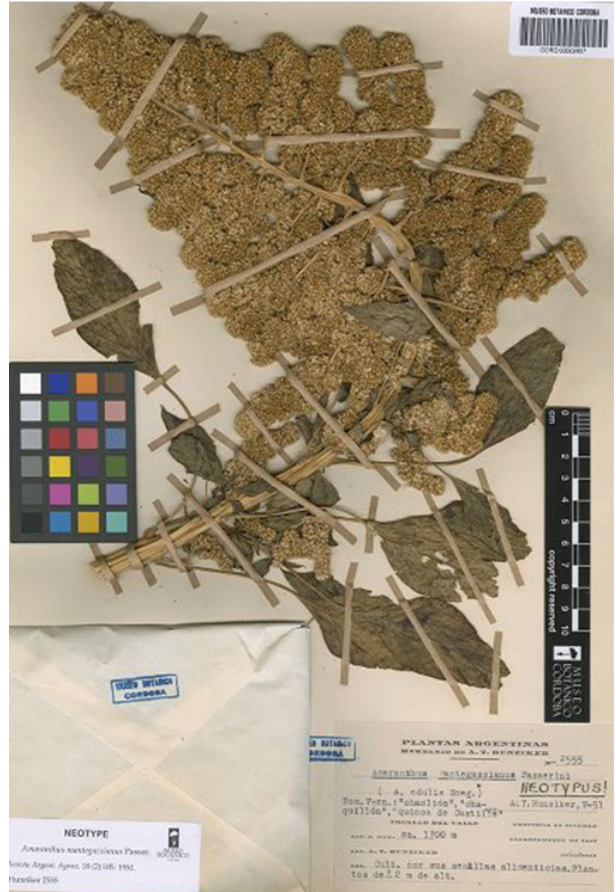
Figure 9. Neotype of the name Amaranthus mantegazzianus (CORD00002607).